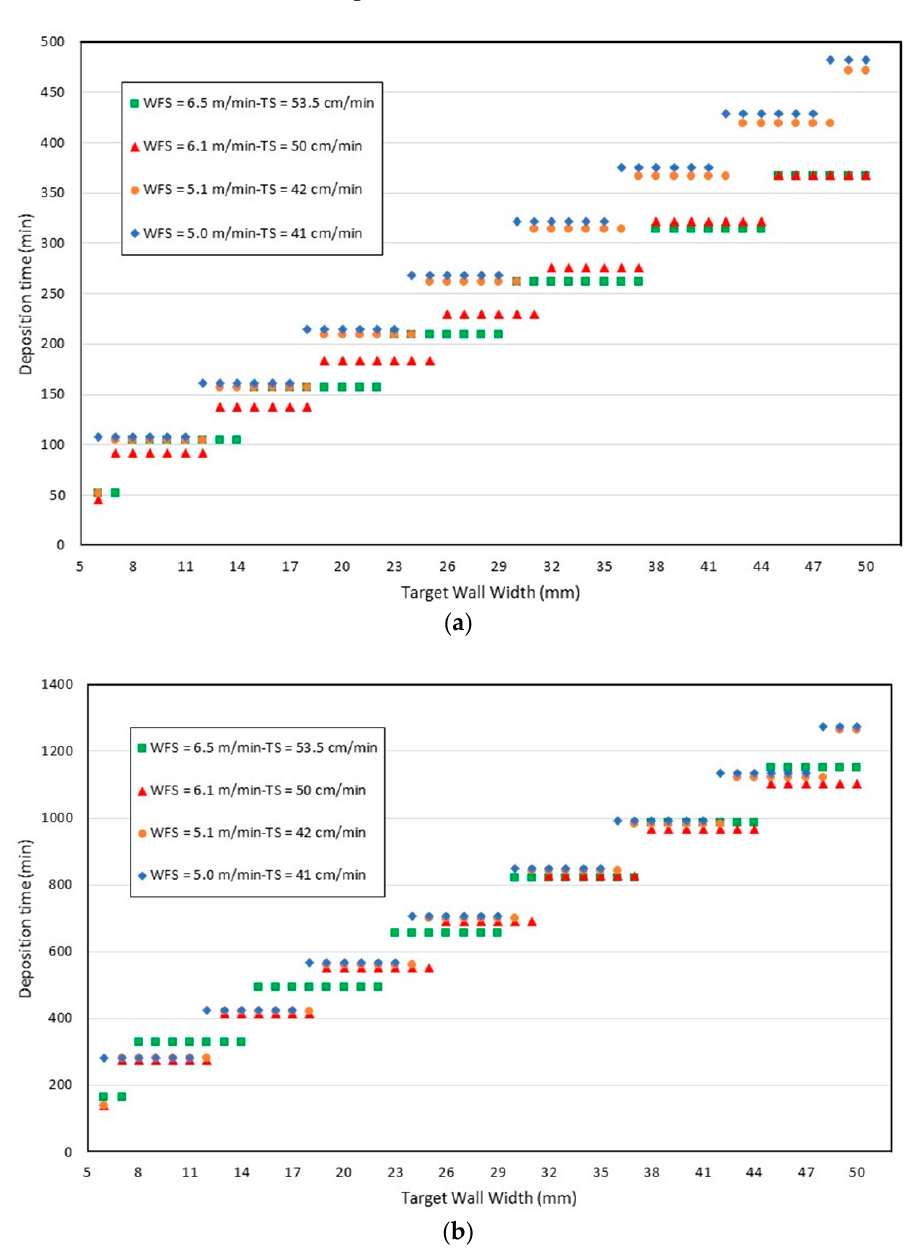
Figure 14. Estimated time spent for WAAM production of aluminum multilayer walls 100-mm high and 500-mm long as a function of the target wall thickness (from 6 to 50 mm), by using the different WFS assessed in Section 2.3: ( a ) no dead time between subsequent layers are accounted; and ( b ) a common 120 s dead time between subsequent layers are accounted.